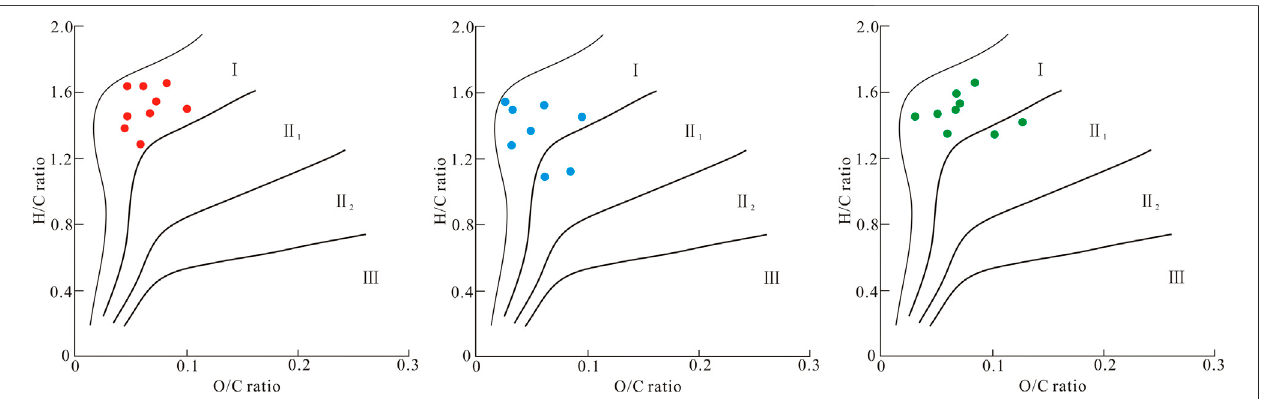
FIGURE 4 | Types of organic matter in the shale of the Wufeng-Longmaxi Formation in southern Sichuan.